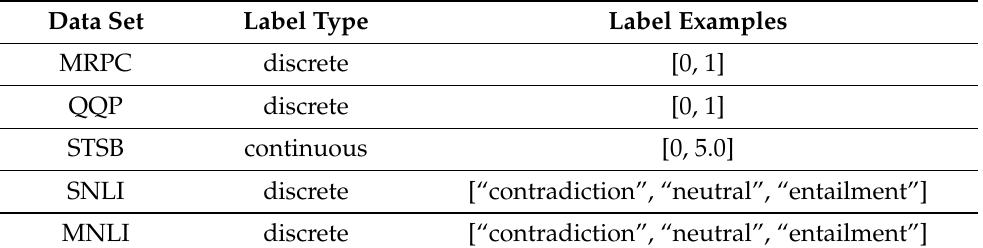
Table 5. Datasets label types being used for relabelling.